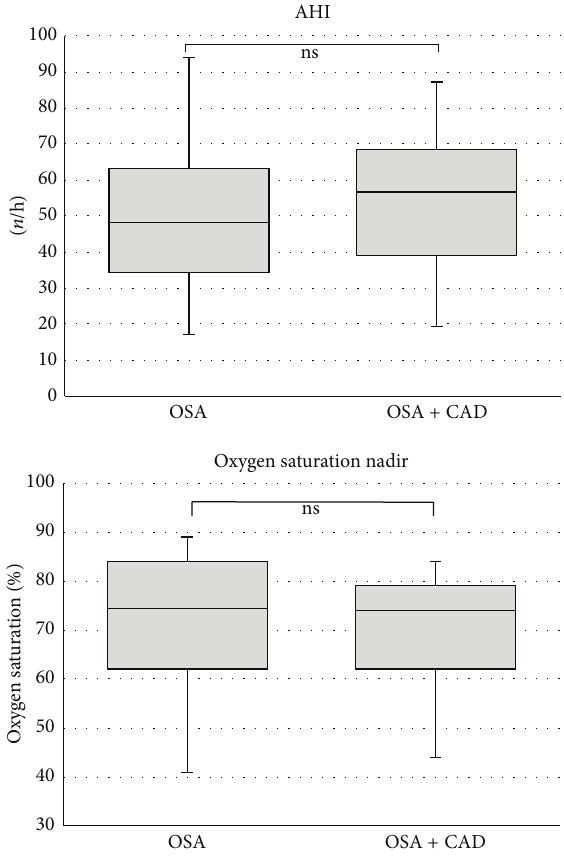
Before sleep After sleep